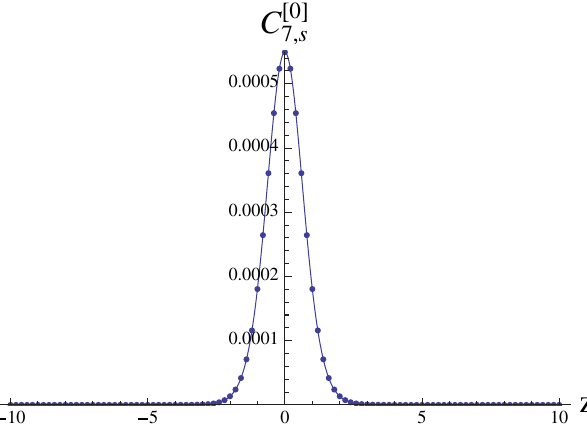
FIG. 13. Exact and numerical results for C ½ 0 (cid:3) 7 are shown as a solid line, and numerical results are shown as